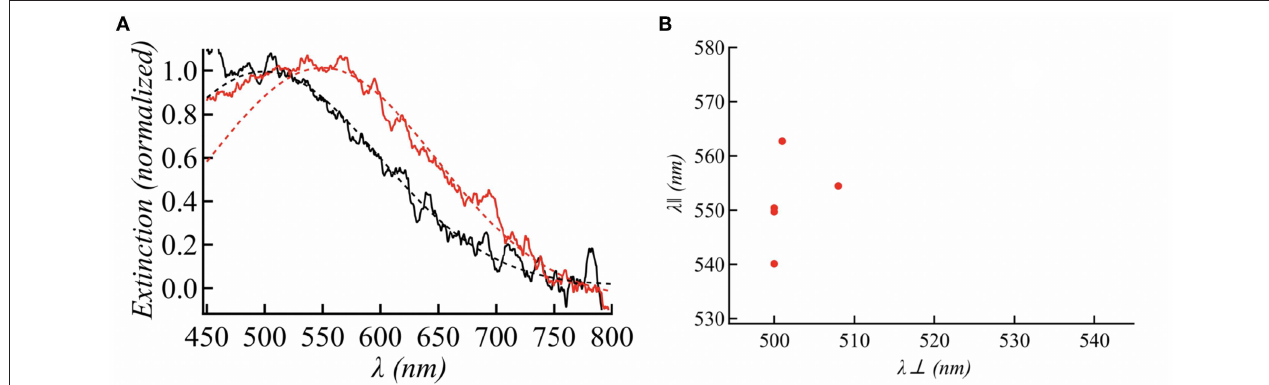
FIGURE 3 | (A) Normalized light extinction spectrum obtained in 8CB oily streaks containing gold NPs of diameter D for the determination of the resonance wavelength. In black is the extinction for light polarization perpendicular to the 8CB oily streak stripes, in red for parallel polarization. (B) The different obtained extinction resonance measurements for NP chains represented by the ( λ nm embedded in 8CB oily streaks.